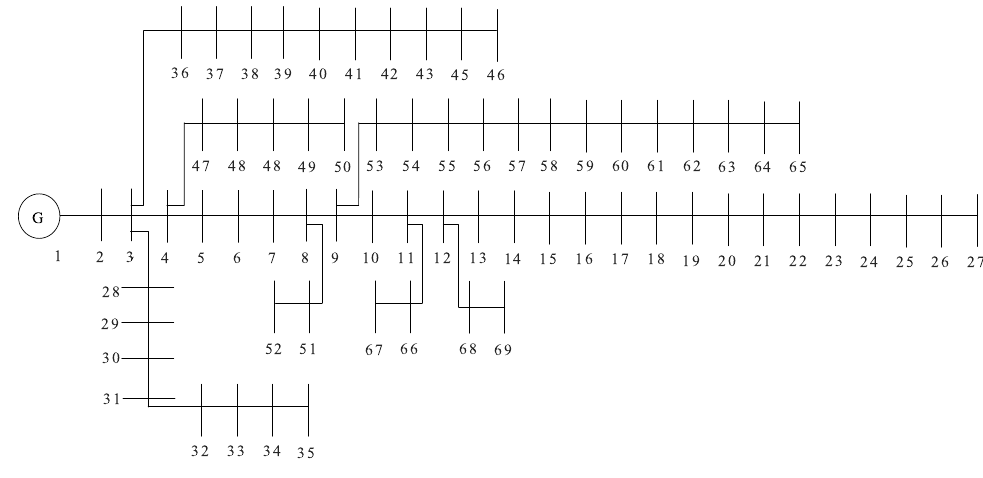
Figure 15. Line diagram of the 69 bus test